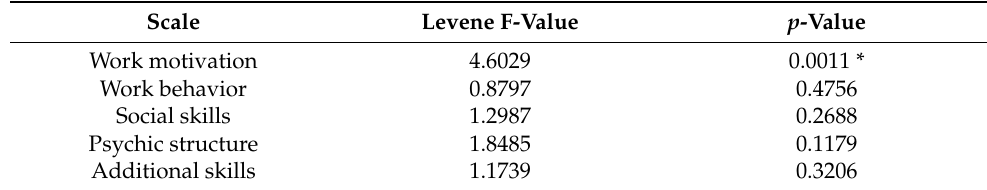
Table 10. Levene test statistics when the sample is differentiated by age range.